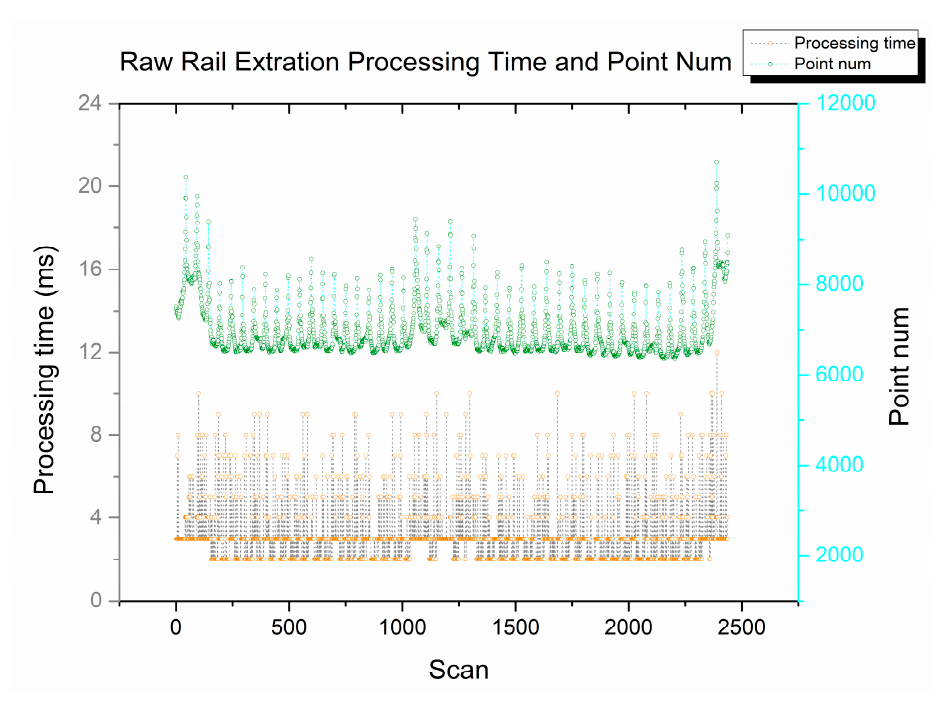
Figure 14. Timing of PCA and raw point number of every second.